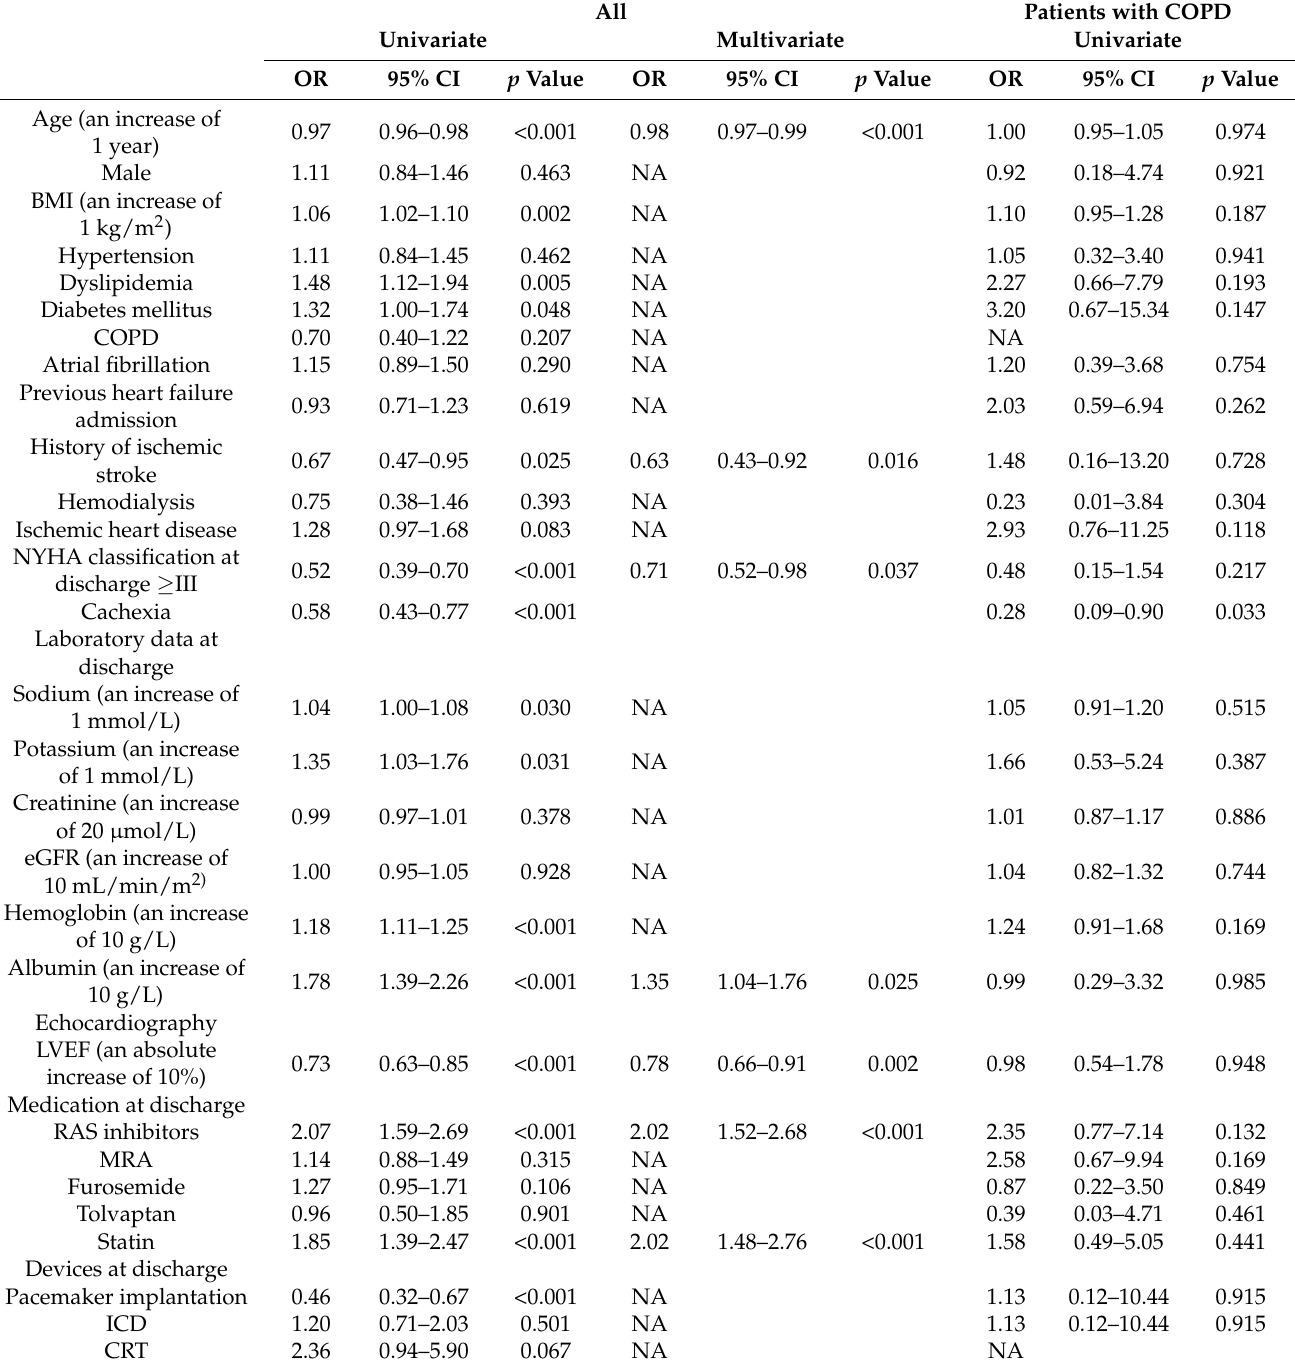
Table 2. Contributors for the prescription of